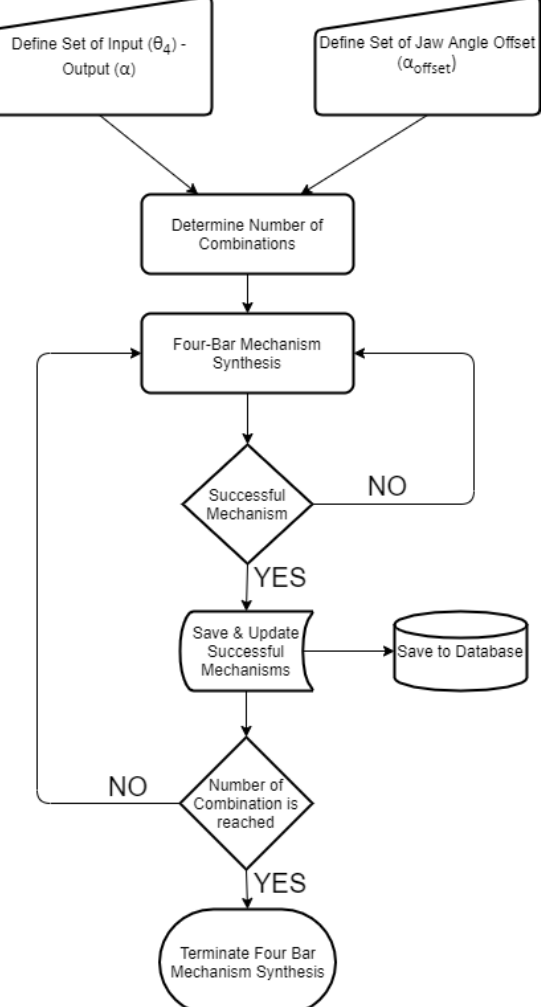
Figure 12. Algorithm for designing the four-bar mechanism at the pharyngeal jaw.